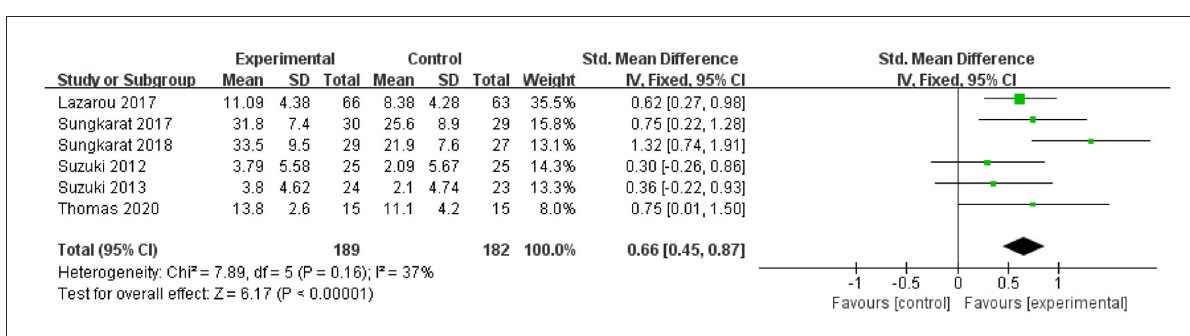
FIGURE6 The influence of exercise interventions on delayed recall.